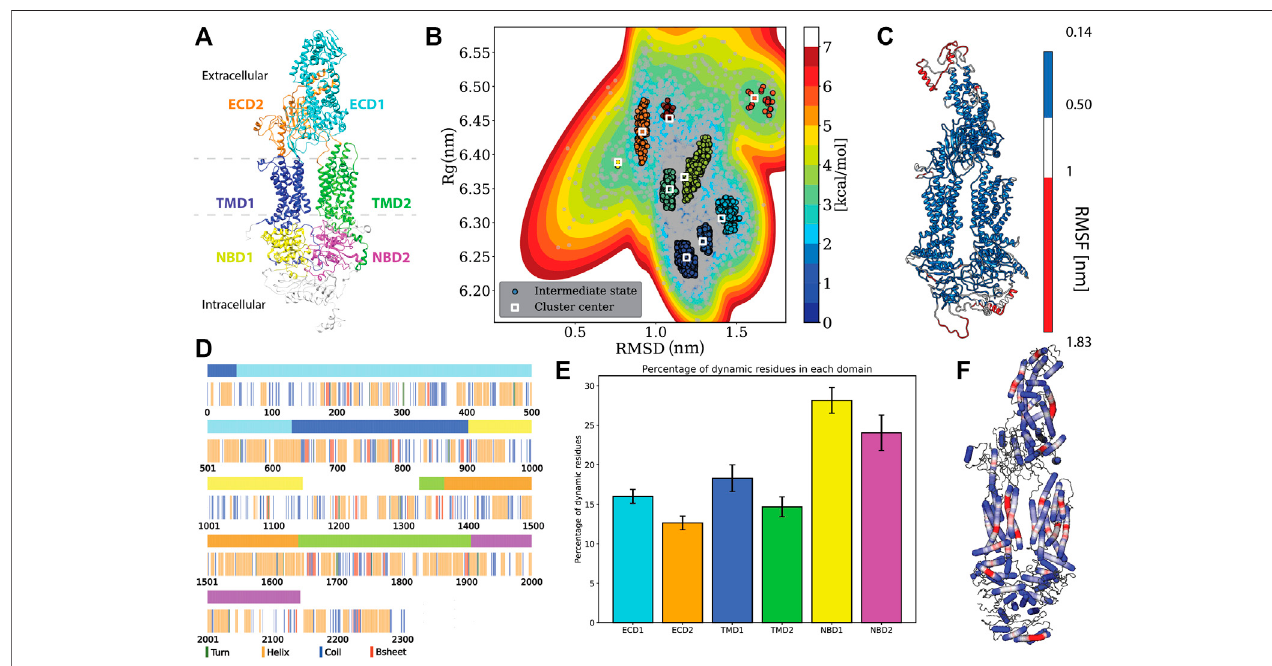
FIGURE1| Proteinspeci fi canalysis. (A) Domain assignment ofABCA1 (accordingtoQianet al.,2017) (B) .Free energy estimationand clusteringshowing distinct minima bins (C) . Root mean square fl uctuation (RMSF) mapped onto the protein that showed the extremities of the protein being susceptible to large fl uctuations. (D) Residue-wiseanddomain-wiseassignmentoffavouredsecondarystructureamongstturn(green),helix(orange),coil(blue),b-strands(red)anddynamicresidues(white) accordingtothe (A) colourscheme(topbar) (E) Percentageofdynamicresiduesineachdomain,wherethecolorofeachbarcorrespondstothedomainsin (A) . (F) Degree of fl exibility of helices constituting the protein where regions in red indicate areas of highest helix axis angle ( > 15 ° ) and fl exibility, white for intermediate angle magnitudes (0 – 15 ° ) and blue for angles close to, or at 0 °